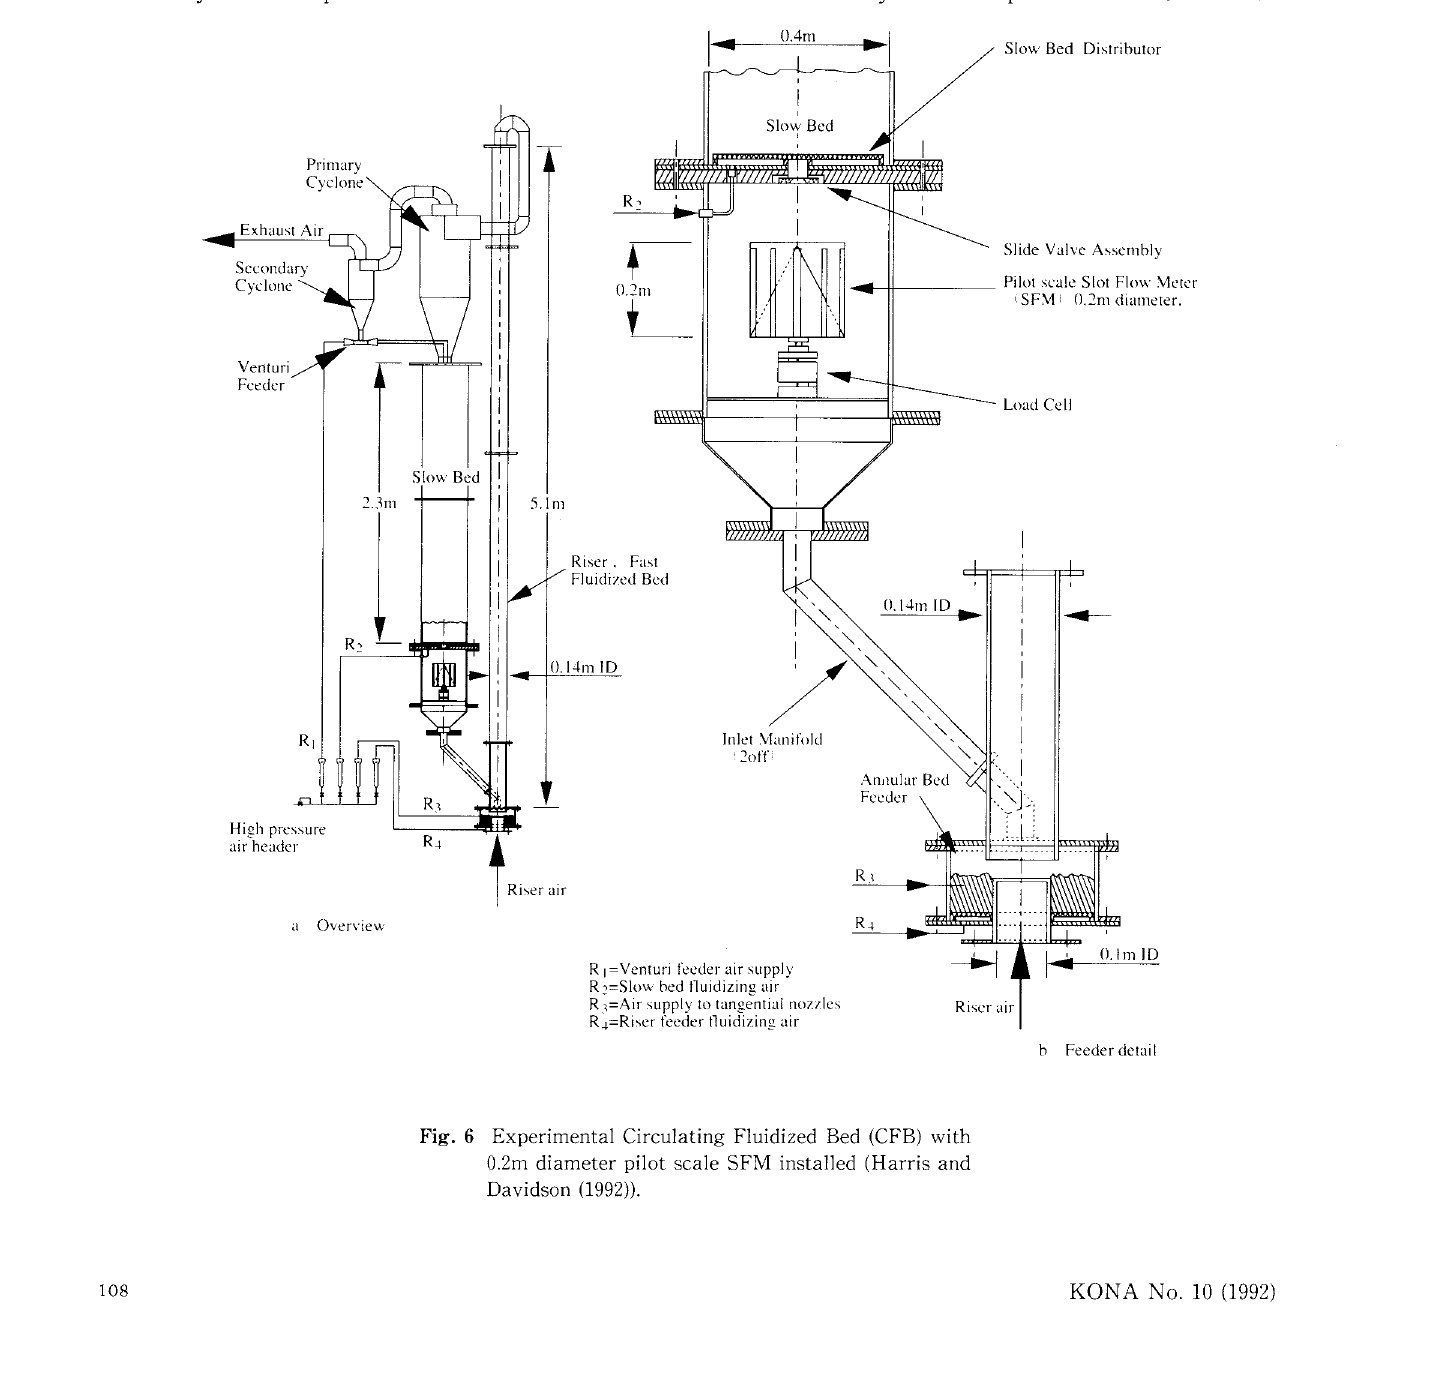
Fig. 6 Experimental Circulating Fluidized Bed (CFB) with 0.2m diameter pilot scale SFM installed (Harris and Davidson